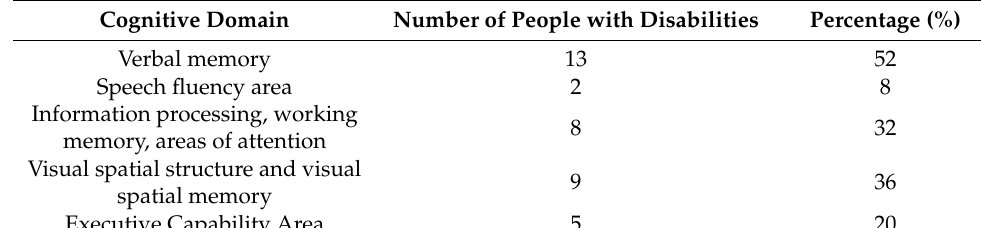
Table 4. Dysfunction of cognitive domains in acute NMOSD.